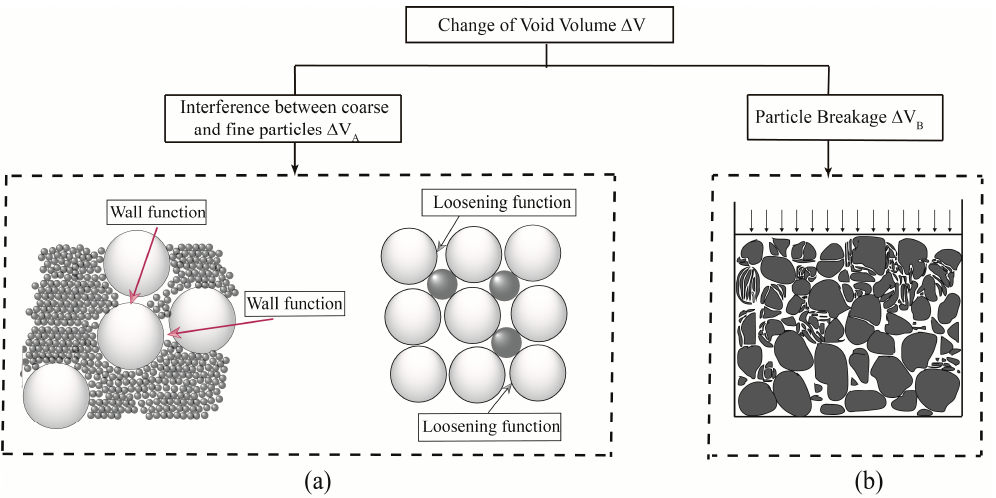
Figure 10. The two parts constituting the change of void volume Δ V : ( a ) Mutual interference between coarse-grained and fine-grained particles Δ V A , ( b )Particle breakage Δ V B . The minimum void ratio of gap-graded SRMs computed using Vallejo and Chang et al. models are